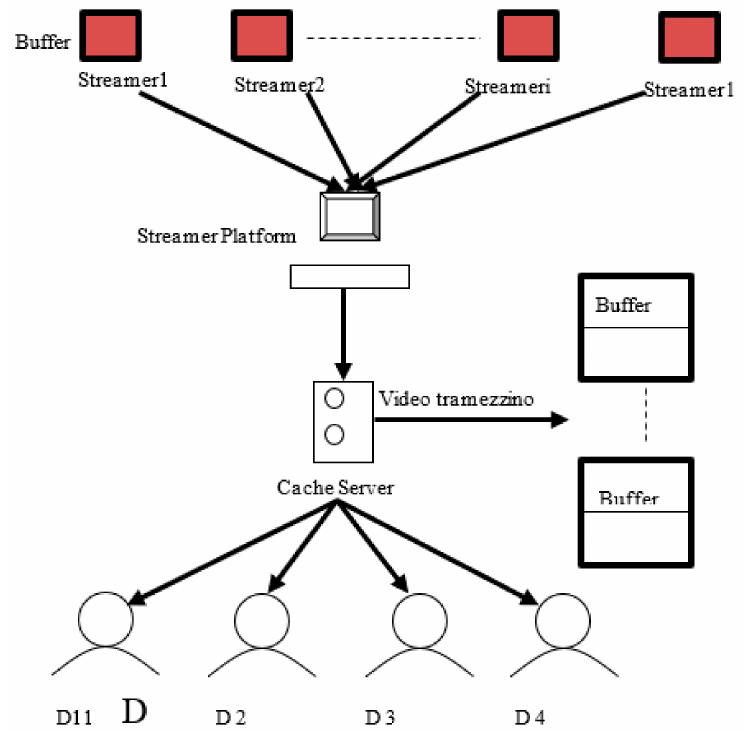
Figure 5. Streaming flow.